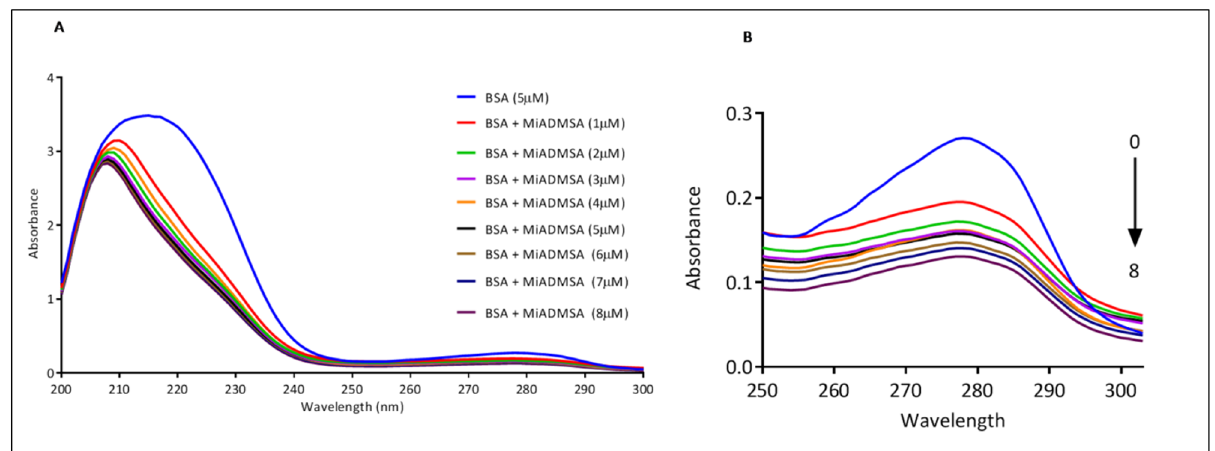
Figure 6. ( A ) UV absorbance spectra of BSA (5 µM) in the presence of MiADMSA (0–8 µM) ( B ) extended view of absorbance spectra of BSA with